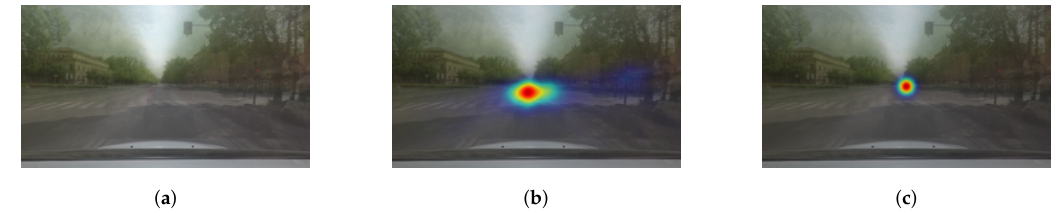
Figure 3. Center-biased attention property of on-road dataset. ( a ) Mean frame. ( b ) Mean attention map. ( c ) Predicted attention map by Gaussian blob. The mean attention map of ( b ) shows that a driver’s attention tends to direct the center of the scene, although it contains objects possibly attracts, for example, traffic signals and signs. The Pearson correlation coefficient of naive estimation between Gaussian blob in ( c ) and ground-truth is 0.5477, which reflects the center-biased data. Please note that the mean frame and attention map are generated by taking the average over the entire frames and ground-truth attention maps of an example